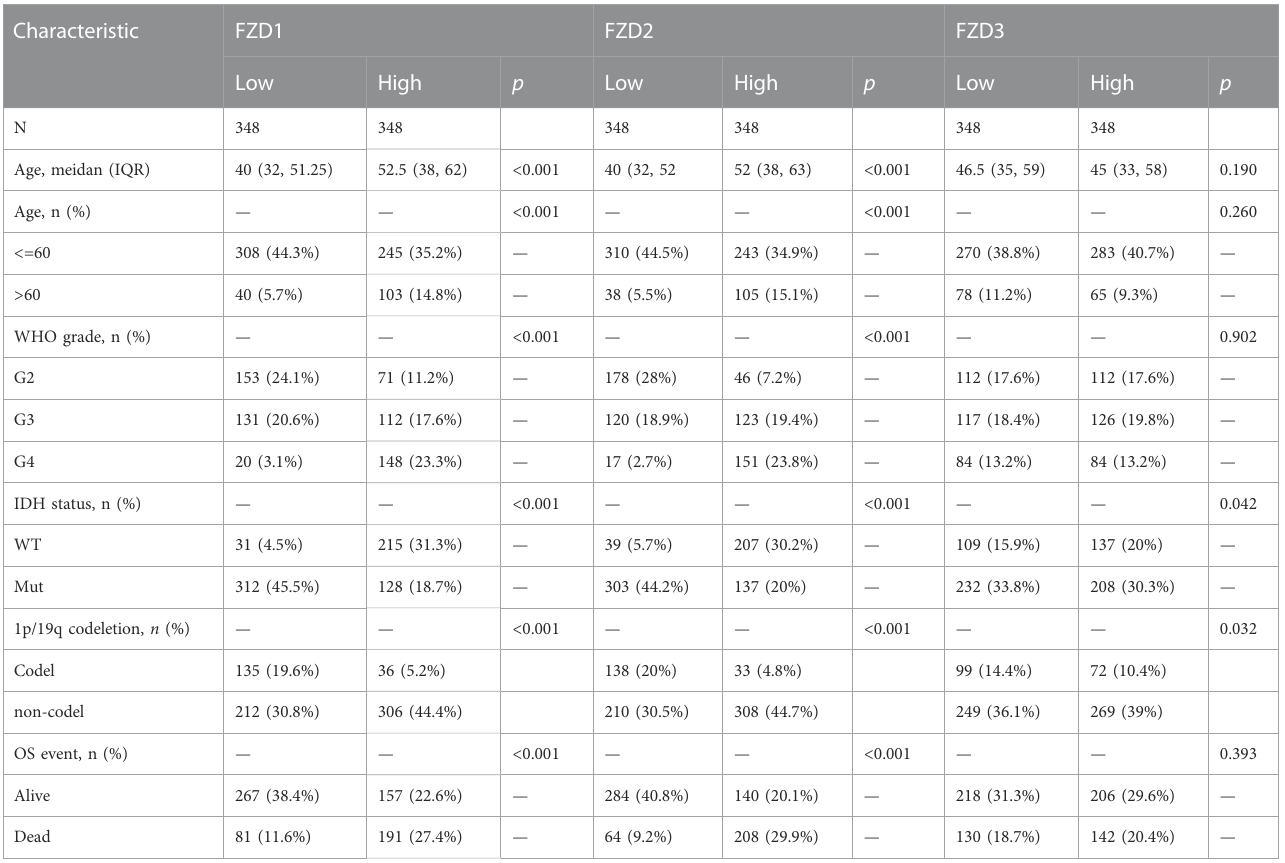
TABLE 1 The FZDs expressions in glioma patients with different clinical parameters.